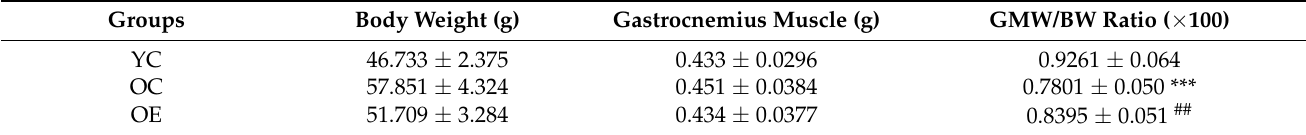
Table 1. Lifelong aerobic exercise alleviated the reduction of the GMW/BW ratio of aged mice.